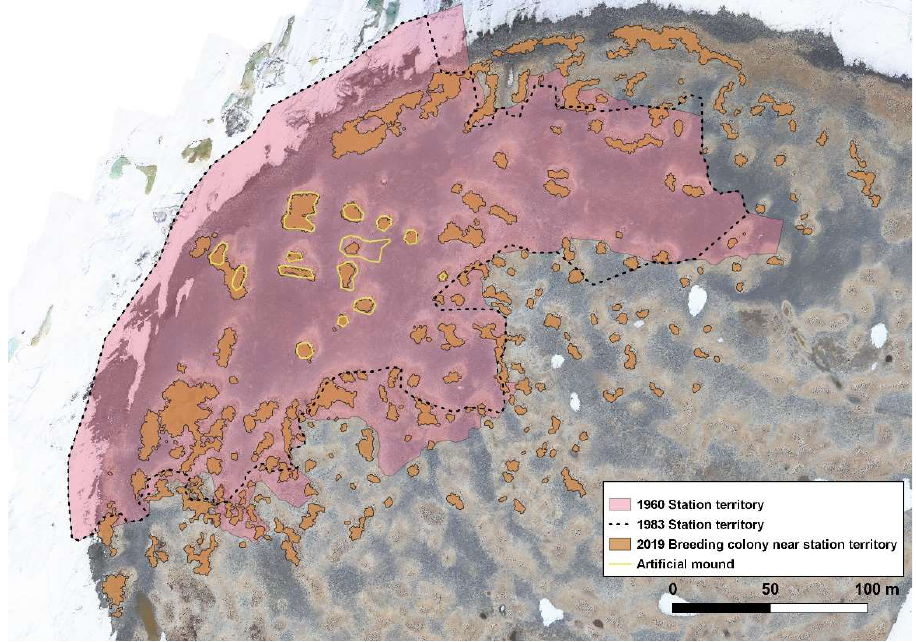
Figure 5. Recolonized penguin colony status after the station clean-up project in 2019. The Ad é lie penguin population has fluctuated at Cape Hallett (Figure 1). The total number of breeding pairs declined dramatically during the station operation period. Once a decline occurs, it seems to continue even though disturbances are removed [11]. Further- more, the Ad é lie penguin population has gone through natural fluctuation for many years and recovered steadily [14]. The population was the highest in 1987, with 66,319 pairs, and the lowest in 2006, with 24,848 counted pairs. Despite the population having decreased and fluctuated, Ad é lie penguin recolonization is a positive result from a long-term point of